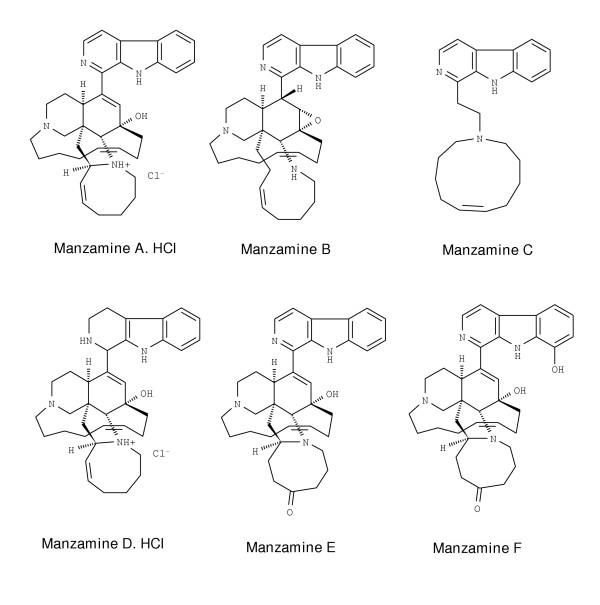
The chemical structures of manzamines A, B, C, D, E and F. Manzamines are indole-derived alkaloids isolated from the marine sponges Haliclona sp. [10], Amphimedon sp. [66] and Xestospongia sp. [10,67]. Molecular weights are respectively = 585.2, 550.8, 347.5, 591.3, 564.7, 580.8.